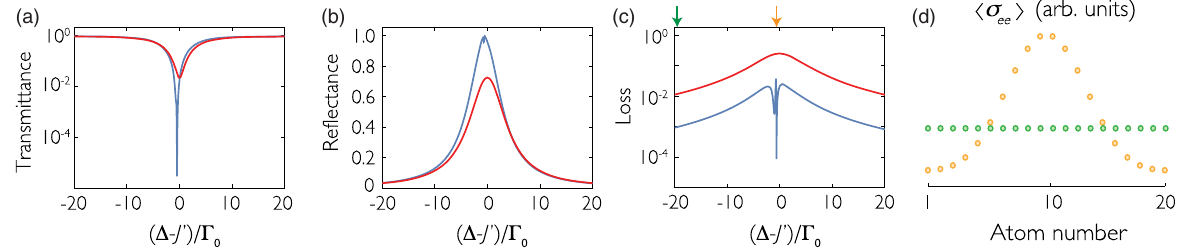
d ¼ π ). (a) Transmittance, D